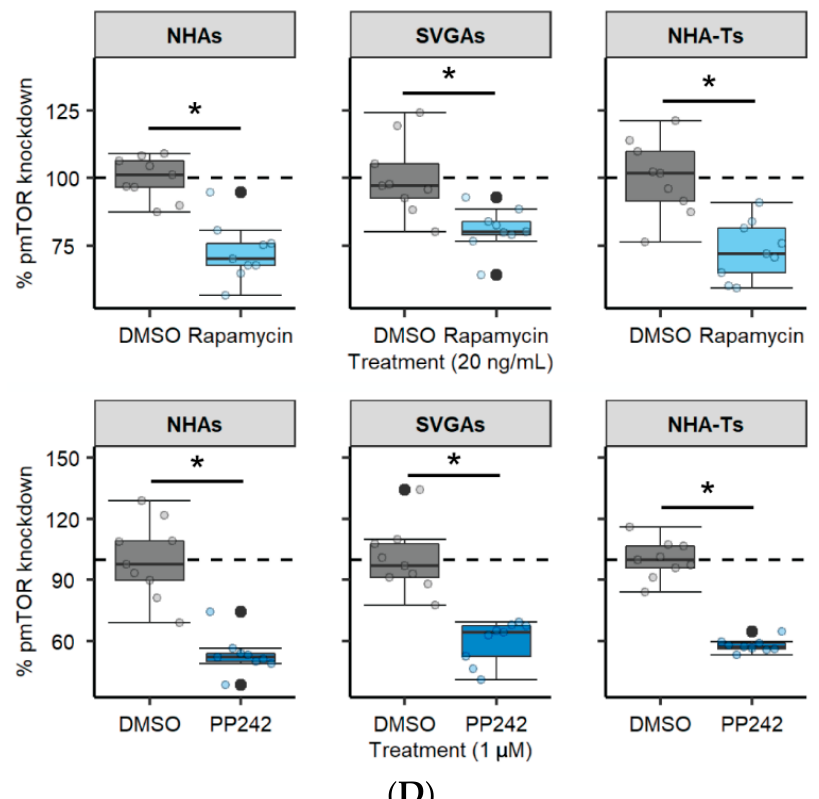
Figure 6. Inhibitors of mTOR, a target of the PI3K/AKT pathway, reduce JCPyV infection in NHAs. ( A , B ). NHAs, SVGAs, and NHA-Ts were pretreated with ( A ) rapamycin at 20 ng/mL, ( B ) PP242 at 1 µ M, or the DMSO control at an equivalent volume control and then infected with JCPyV (MOI = 1.0 FFU/cell) at 37 ◦ C for 1 h. Cells were incubated in media containing DMSO or mTOR inhibitors for 72 h and then fixed and stained by indirect immunofluorescence. Infectivity was determined by counting the number of JCPyV T Ag- or VP1- positive nuclei divided by the number of DAPI-positive nuclei for five × 20 fields of view for triplicate samples (% infection). Data is representative of three individual experiments performed in triplicate. Error bars indicate SD. Student’s t test was used to determine statistical significance comparing DMSO to either mTOR inhibitor, with each cell type and viral protein. ( C ) All cell types were treated with DMSO or rapamycin at 20 ng/mL (top) or PP242 at 1 µ M (bottom) at 37 ◦ C for 24 h. Cells were fixed and stained for pAKT (green) or CellTag (red). Entire wells of a 96-well plate are shown. ( D ) Percentage of pmTOR for each cell type was quantitated by ICW signal intensity values per [(pmTOR)/Cell Tag × 100% = % response] within each ICW analysis with LI-COR software (representative image shown in C ). Box and whisker plots represent the distribution of samples (individual points) with the lower quartile, median, and upper quartile denoted as black lines. The dashed line indicates the normalized DMSO % response of pmTOR. Colored points represent individual points for each treatment (3 replicates, performed in triplicate), and outliers are represented by black circles. A Wilcoxon rank sum exact test was used to compare treatments in each cell type. Data are representative of three independent experiments performed in triplicate. *, p <